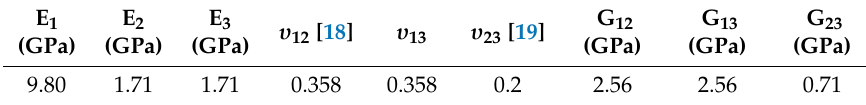
Table 3. The material properties of specimens.